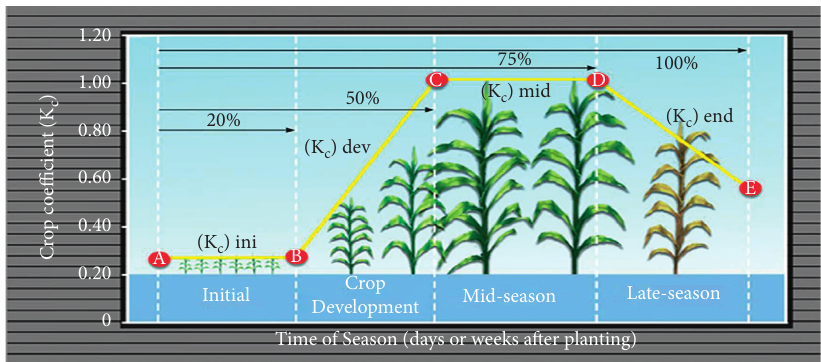
Figure 2: The relationship between crop coefficient � Kc and time of season, which varies according to crop time of season (days or weeks after planting) at different stages [7]: crop coefficient initial (20% of seasonal time from A to B); crop coefficient development (50% of seasonal time from B to C); crop coefficient mid-season (70% of seasonal time from C to D), and crop coefficient late-season (100% of seasonal time from D to